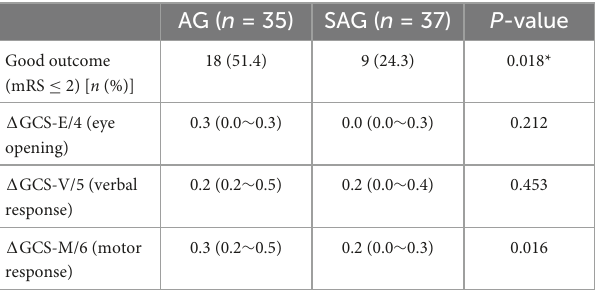
TABLE 5 Change from t1 to t3 in GCS subscale values and outcomes in